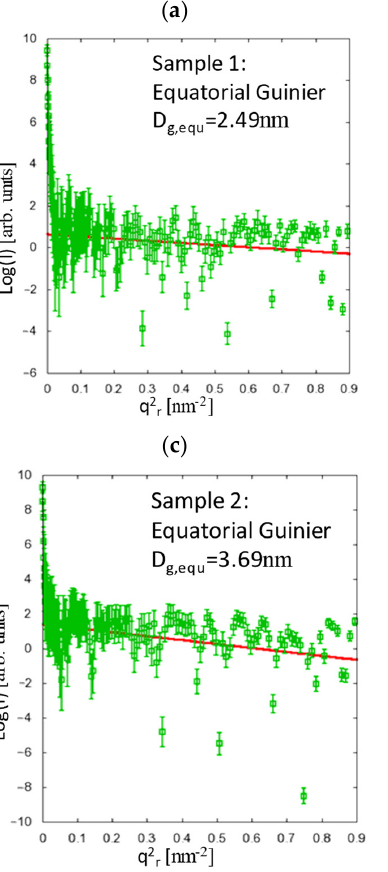
Figure 3. Analysis of the equatorial scattering contributions using the Guinier fit for sample 1 ( a ), sample 1* ( b ), sample 2 ( c ) and sample 3 ( d ). The results show that the equatorial dimensions appear to be dependent on the spin-draw ratio rather than the draw ratio.